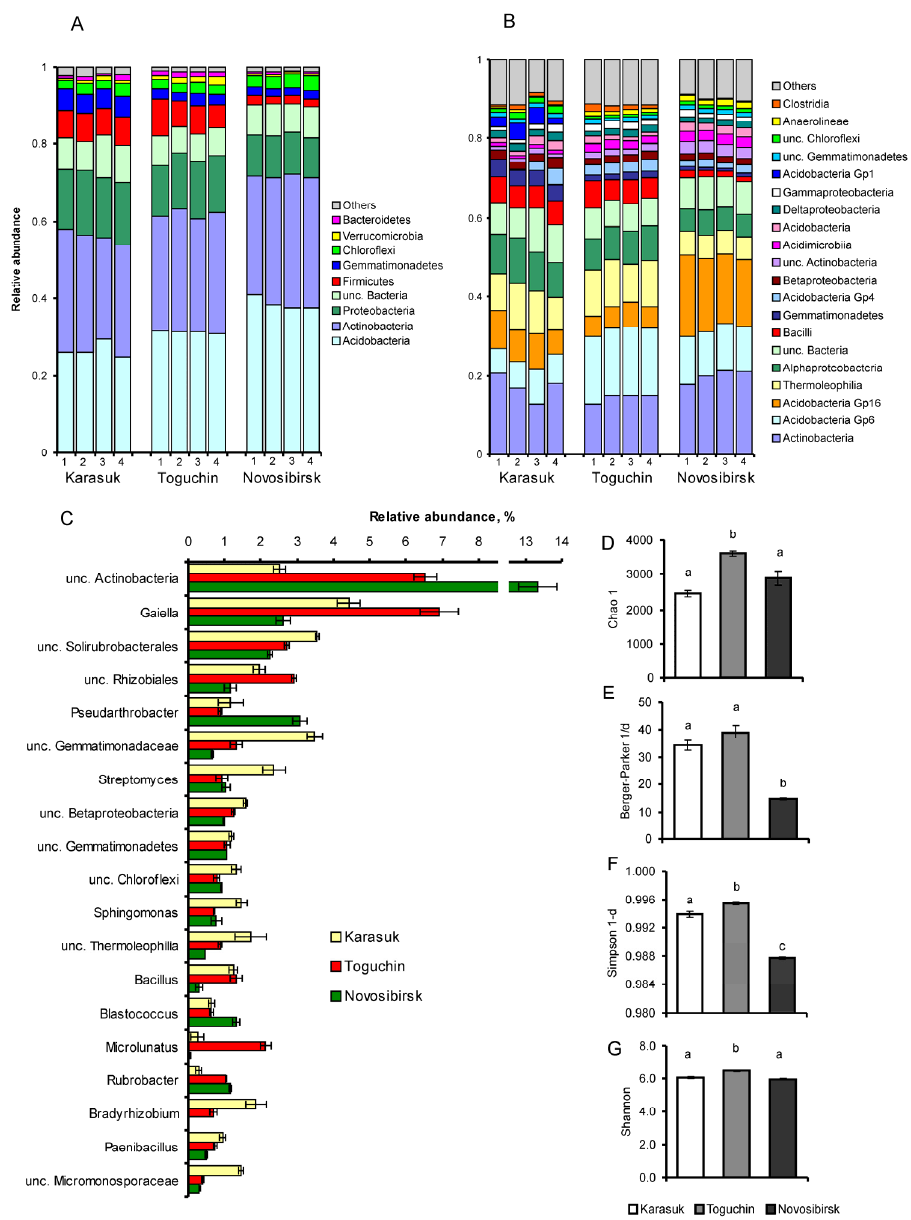
Figure 2. A 16S metabarcoding analysis of bacterial communities in the soils of potato fields with different levels of fungistasis and different agricultural practices: Karasuk (kitchen gardens, high level of fungistasis), Toguchin (kitchen gardens, intermediate level of fungistasis), and Novosibirsk (conventional fields, low fungistasis). Four samples for each soil are presented: ( A ) the distribution at the level of phyla; ( B ) the distribution at the class level; ( C ) the distribution at the level of genera; and ( D – G ) diversity indices. Different letters denote significant differences (Tukey’s test or Dunn’s test, p <